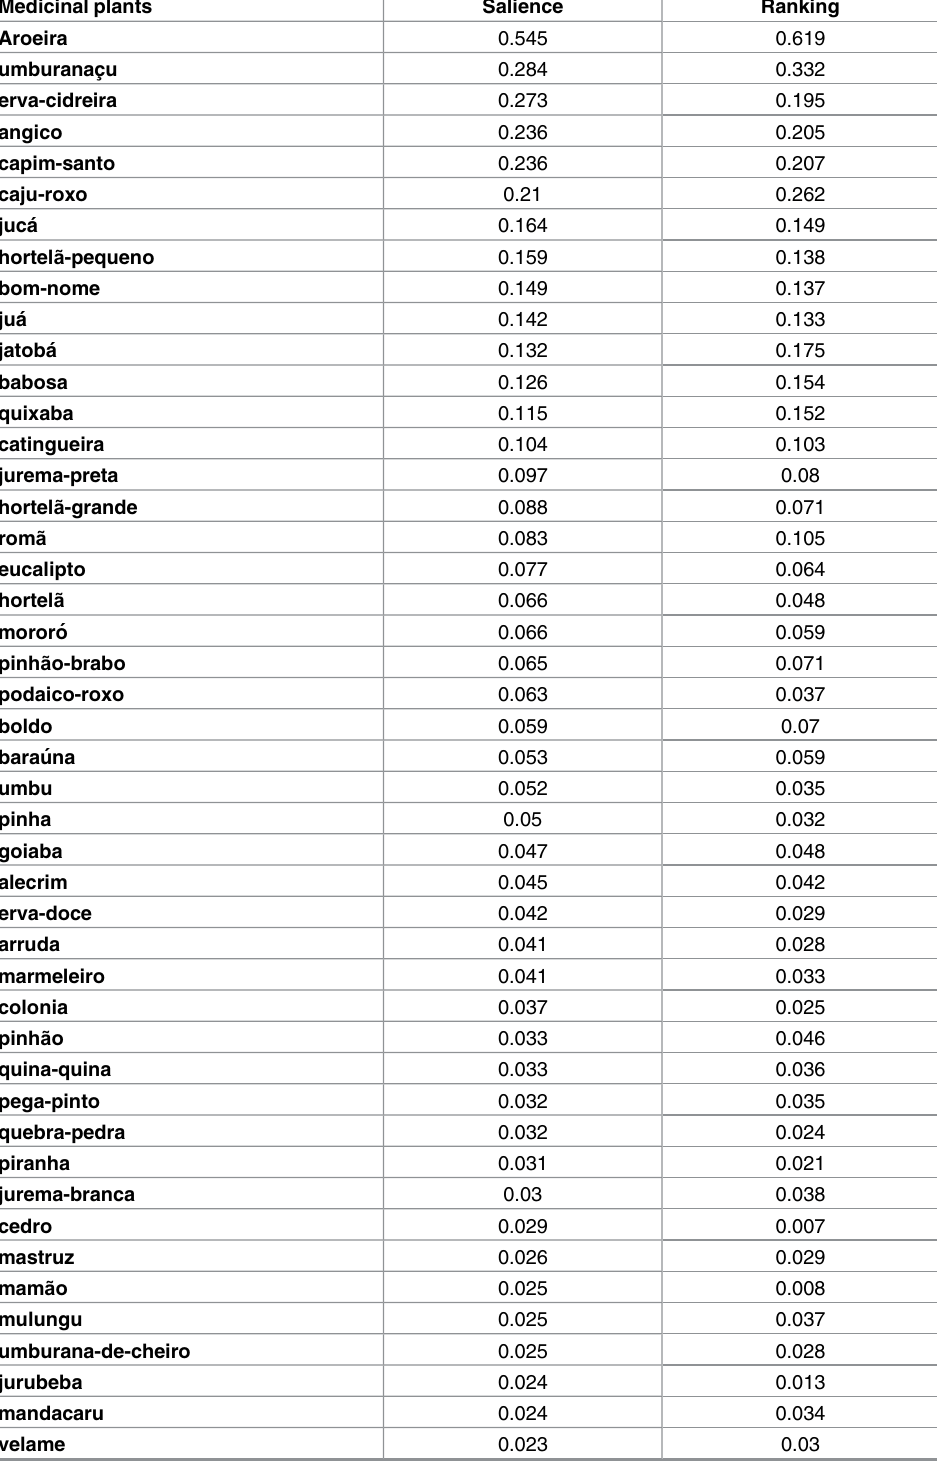
Table 3. List of medicinal plants, their salience values in free lists, and their ranking, as determined in the community of Car ã o in the state of Pernambuco in northeastern Brazil. Medicinal